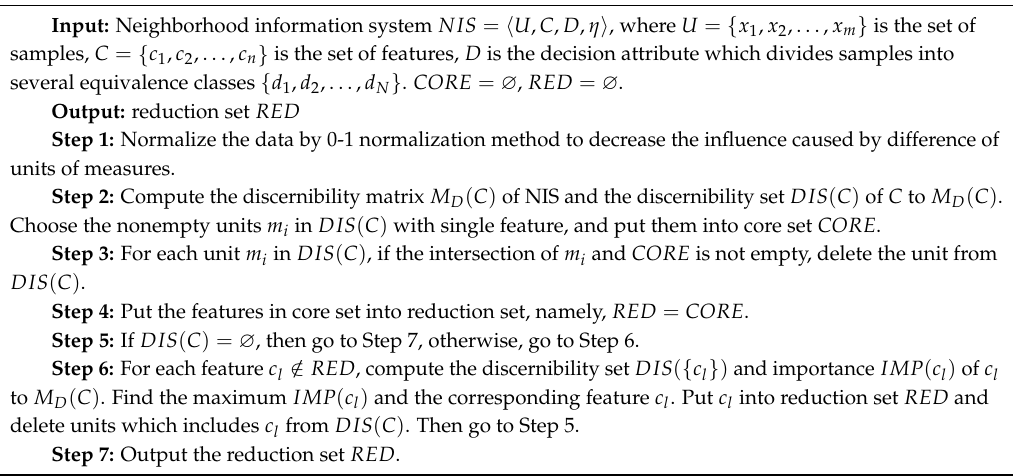
Algorithm 1: Feature Selection Strategy Based on NRS and Discernibility